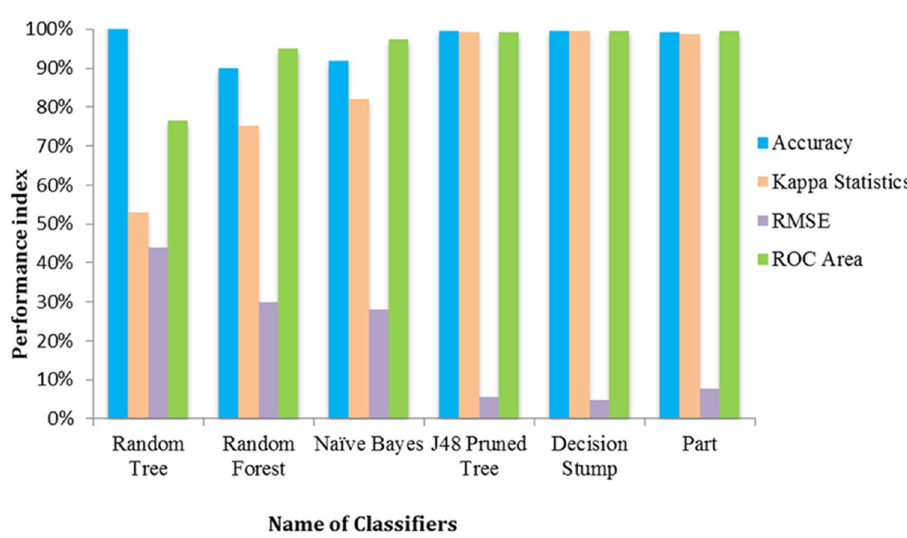
Figure 3. Predictive performance evaluation of classifiers using machine